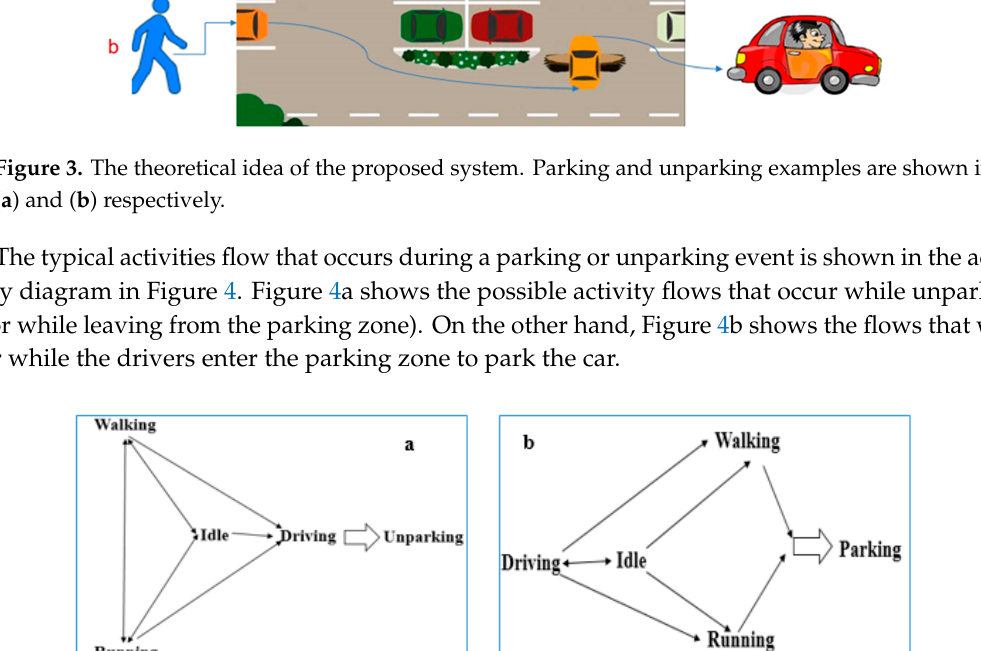
Figure 4. Activity theory diagram of typical activity flows for parking and unparking. Unparking and parking activity flows are shown in ( a ) and ( b ) respectively.